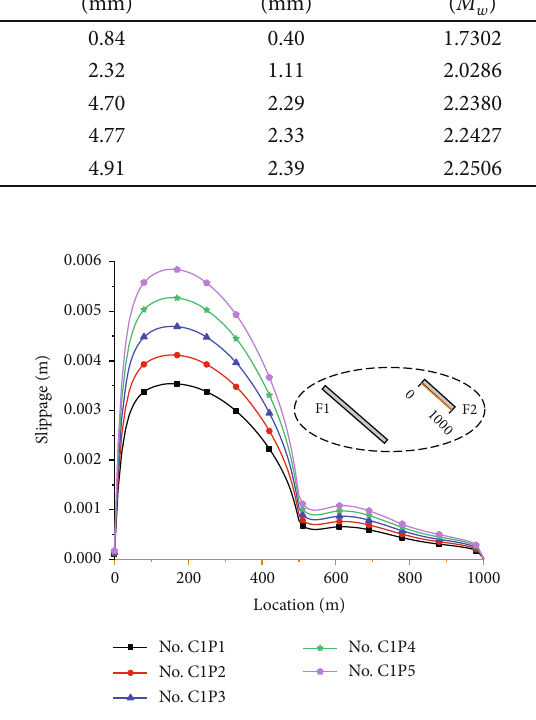
Table 7: The induced slippage and moment magnitude of faults F1 and F2 under di ff erent permeability of the fracturing region. Experiment No.